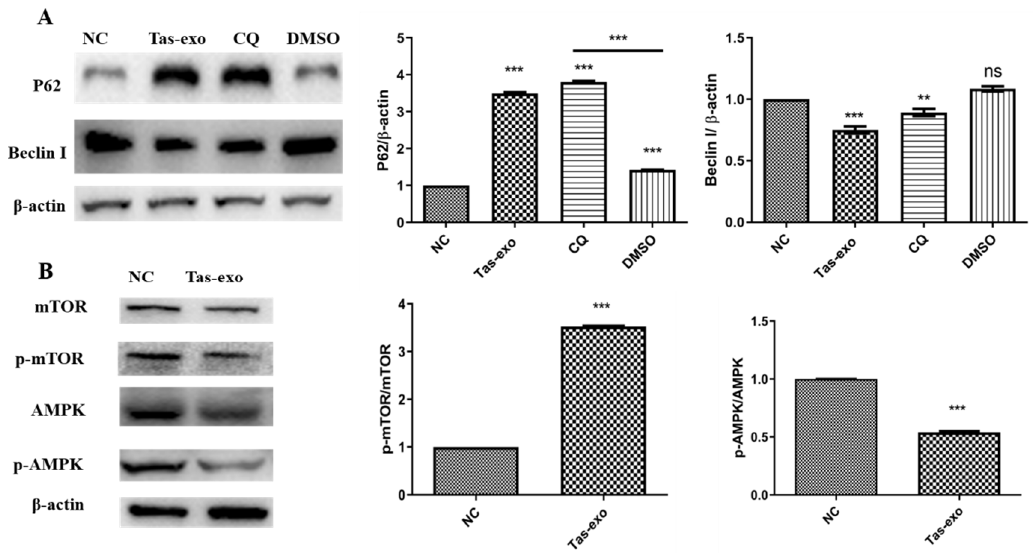
Figure 8. Western blot analysis of autophagy-related protein-expression changes and changes in autophagy-pathway-related proteins in LoVo cells after exosome treatment. ( A ) Beclin І and P62 levels evaluated in Tas-exo and NC groups. ( B ) AMPK and p-AMPK levels, and mTOR and p-mTOR levels evaluated in Tas-exo and NC groups. Analysis of variance performed with t -test; data shown as mean ± SD (** P < 0.01, and *** P < 0.001).